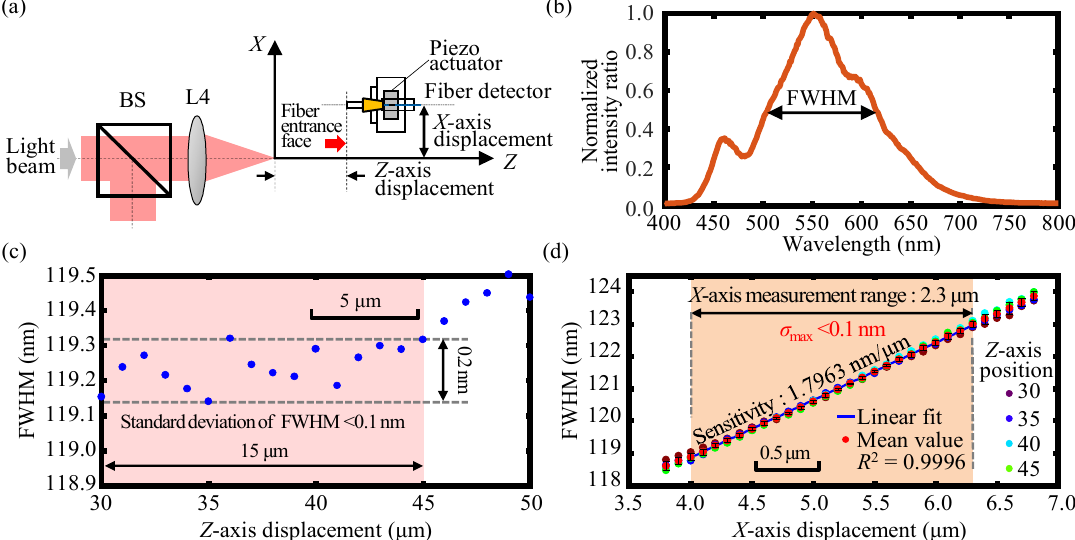
Figure 8. Definition ( a ) of the X -axis and Z -axis coordinates and the experimental results of ( b ) the obtained output spectrum by the fiber detector and ( c ) the variation of the FWHM within a Z -axis displacement range of 15 µ m together with ( d ) the linear decoding of FWHM- X curves in the corresponding Z -axis displacement range of 15 μm.